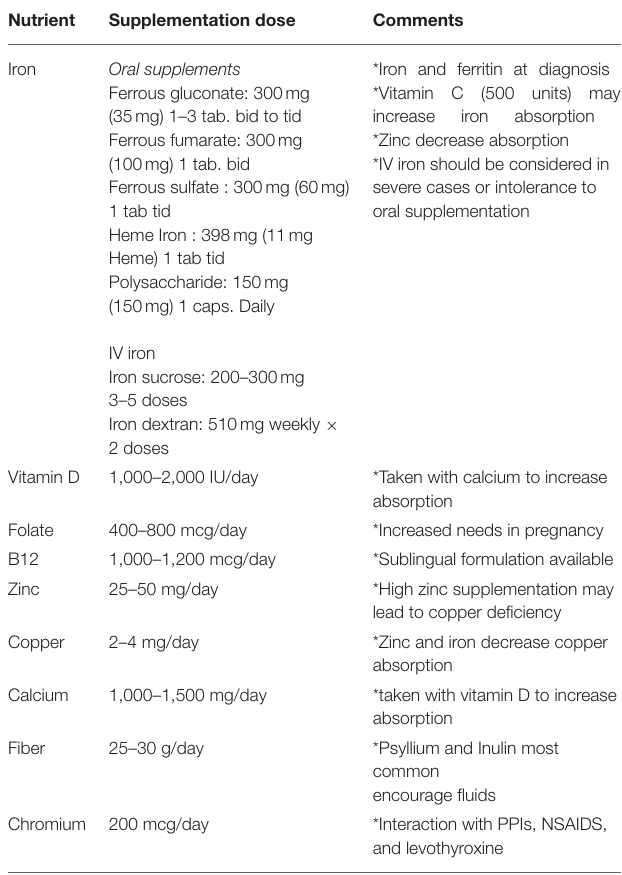
TABLE 2 | Common nutrient deficiencies in the follow up of adult patients with CeD and recommended oral supplementation.